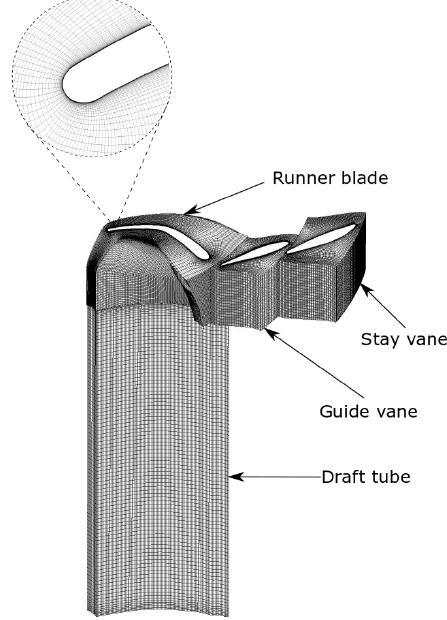
Figure 3. Computational domain of San Francisco’s Francis turbine.